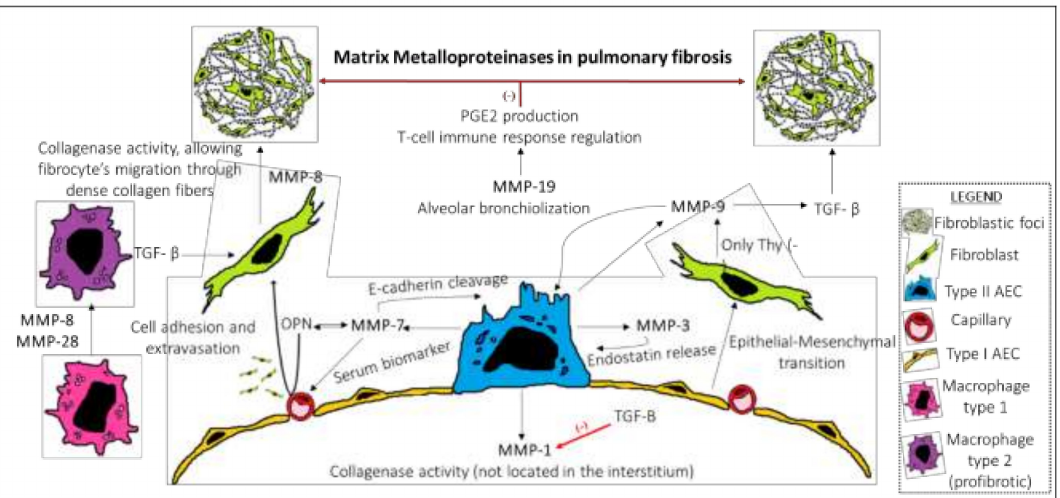
Figure 1. Proposed model of MMPs role in pulmonary fibrosis. Alveolar epithelial type 2 (AE2) cells play a central role in the pro-fibrotic response after repeated lung epithelial injury through several mechanisms, including the upregulation of several matrix metalloproteinases (MMPs). MMP-1 has collagenase activity; however, the location of this protease is not in the interstitium and does not break down the extra-cellular matrix (ECM) proteins. Additionally, MMP-1 is downregulated by TGF- β . MMP-3 has a role in the transformation of epithelial cells to mesenchymal cells, which are producers of ECM proteins, such as type I collagen. MMP-3 is also involved in the release of endostatin, which induces AEC apoptosis. MMP-7 has a crosstalk interaction with osteopontin (OPN), which enhances the MMP-7 production and promotes endothelial adhesion and extravasation of cells, including fibrocytes, which are a precursor of tissue fibroblasts. MMP-7 cleaves E-cadherin and contributes to AEC activation. Additionally, MMP-7 has been validated as a serum biomarker in IPF. MMP-8 has collagenase activity and allows fibrocytes to migrate through interstitial collagen fibers. MMP-9 is produced by AE2 and Thy (-) fibroblasts and enhances the activity of TGF- β , which is a growth factor related to the stimulation of fibroblasts and interstitial fibrosis development. MMP-9 is also related to abnormal alveolar bronchiolization. MMP-19 has antifibrotic properties linked to the production of prostaglandin E2 through the stimulation of prostaglandin-endoperoxide synthase 2. Regulation of adaptative immune cell response has also been related to MMP-19 antifibrotic e ff ects. MMP-28 promotes the macrophage M1-M2 phenotypic switch, as well as